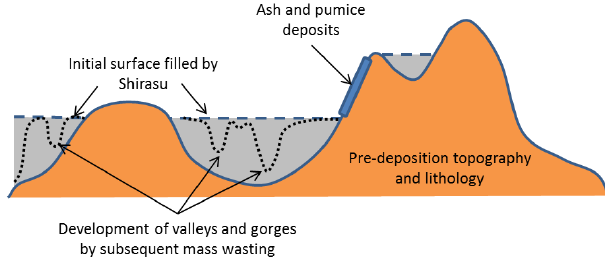
Figure 2. Schematic illustration of the dominant deposition patterns of pyroclastic materials (Shirasu) and the subsequent hydrogeomor- phic processes that induced various types of sediment